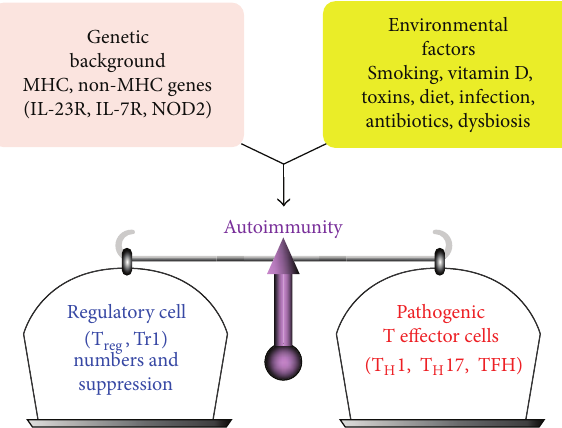
Figure 1: The balance of immunity. A combination of host genetic factors and exposure to environmental triggers promote the development of autoimmune disease. A balance must be maintained between the regulatory T cells and the pathogenic T effector cells.